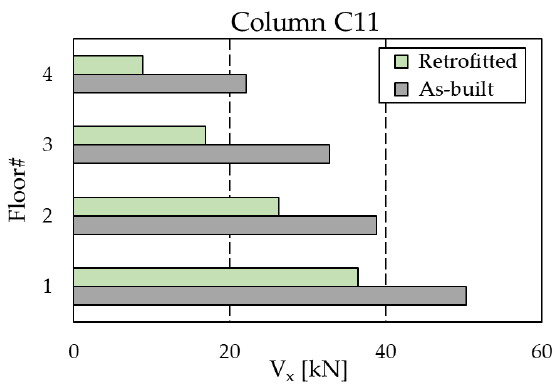
Figure 19. Maximum shear forces in the most stressed column (position C11 in Figure 12a) of the RC structure.